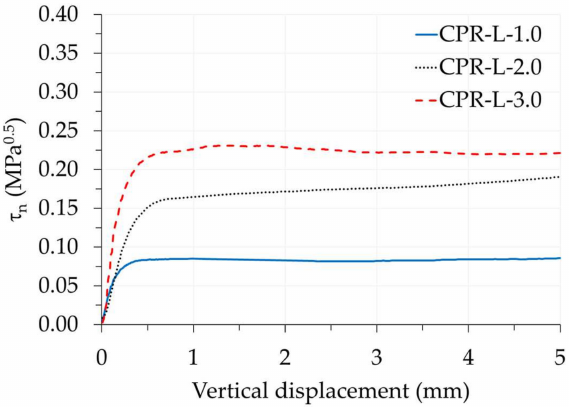
Figure 13. Normalized shear stress versus relative vertical displacement curves for the flat RAC dry joint specimens.